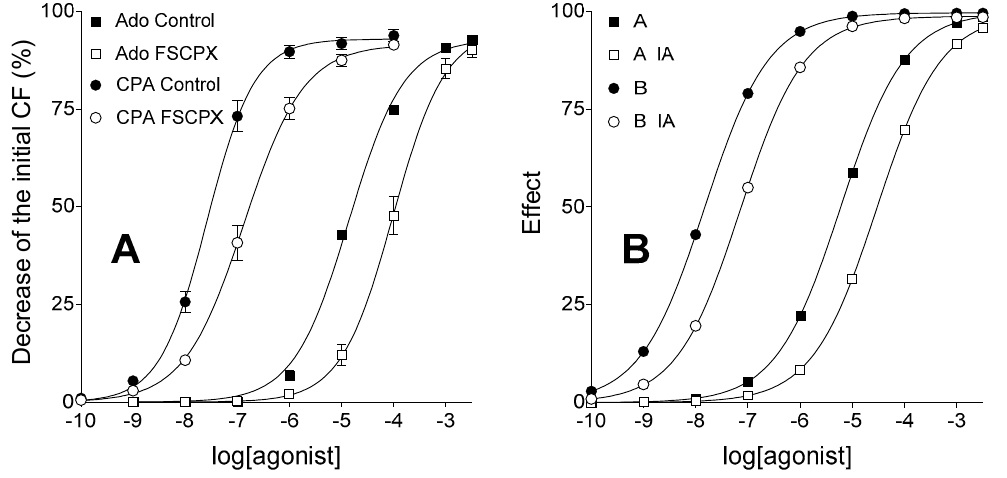
Figure 1. Ex vivo biological (panel A ) and in silico simulated (panel B ) models showing concentration- response (E/c) curves of two agonists with short (square symbols) and long (circle symbols) half-lives, acting in systems with unaffected (filled symbols) and reduced (open symbols) receptor number. The x -axis shows the common logarithm of the molar concentration of agonists (in the bathing medium), and the y -axis indicates the effect. The continuous lines denote the fitted Hill equation. On the panel A , symbols show mean ± SEM. Ado: adenosine (the endogenous A 1 adenosine receptor agonist with a short half-life); CPA: N 6 -cyclopentyladenosine (a synthetic A 1 adenosine receptor agonist with a long half-life); FSCPX: a prior treatment with 8-cyclopentyl- N 3 -[3-(4-(fluorosulfonyl)benzoyloxy)propyl]- N 1 -propylxanthine (an irreversible A 1 adenosine receptor antagonist); A: agonist A (simulating adenosine); B: agonist B (simulating CPA); IA: a prior treatment with an irreversible antagonist (simulating an FSCPX pretreatment); CF: contractile force. Data of panel A are redrawn from [31].